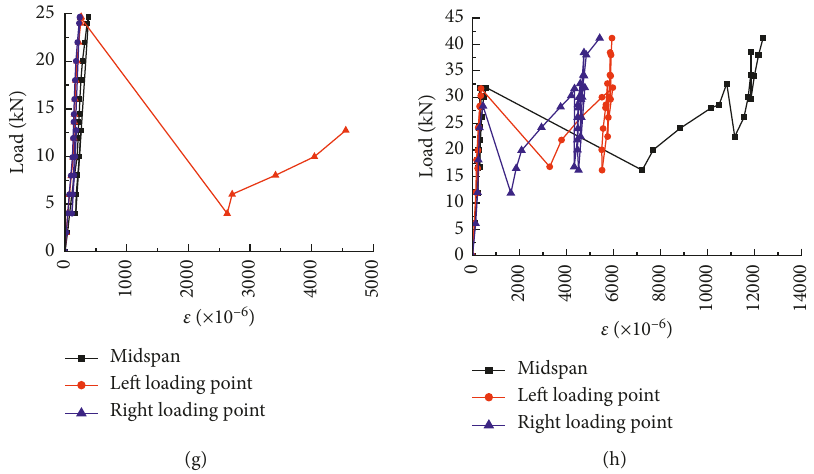
Figure 35: Strain screw-thread steels and CFRP bars: (a) GB-1; (b) GB-2; (c) GB-3;(d) GB-4; (e) GB-5; (f) GB-6; (g) CB-1; (h)